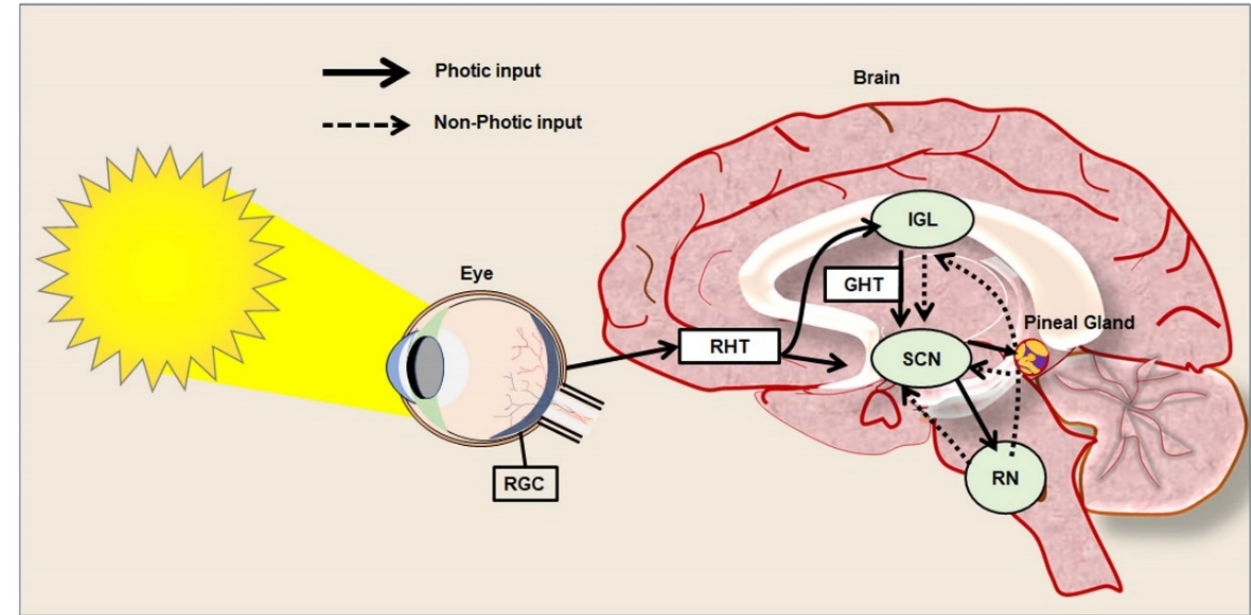
Figure 1. Photic and non-photic input of circadian rhythm in the healthy brain. The digital diagram represents the photic and non-photic inputs from the retina to the brain and neural pathways among the hypothalamus, pineal gland, and raphe nucleus (RN) that regulate circadian rhythm in a healthy brain. The straight line represents the photic inputs and the dotted line represents the non-photic inputs. The photic information